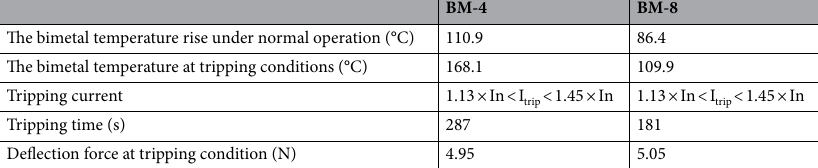
Table 6. A comparison of the performance of BM-4 and BM-8 bimetals under the same conditions.